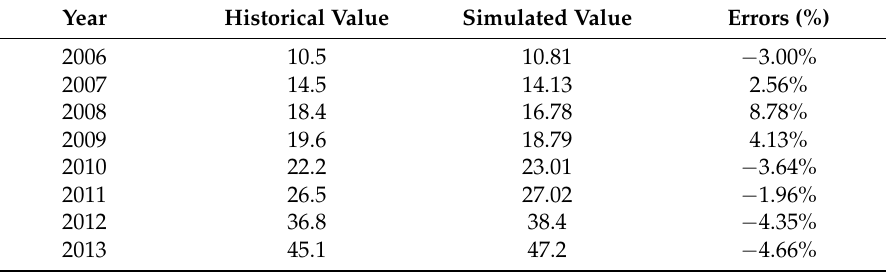
Table 4. Simulated errors of the annual production capability (billion cubic